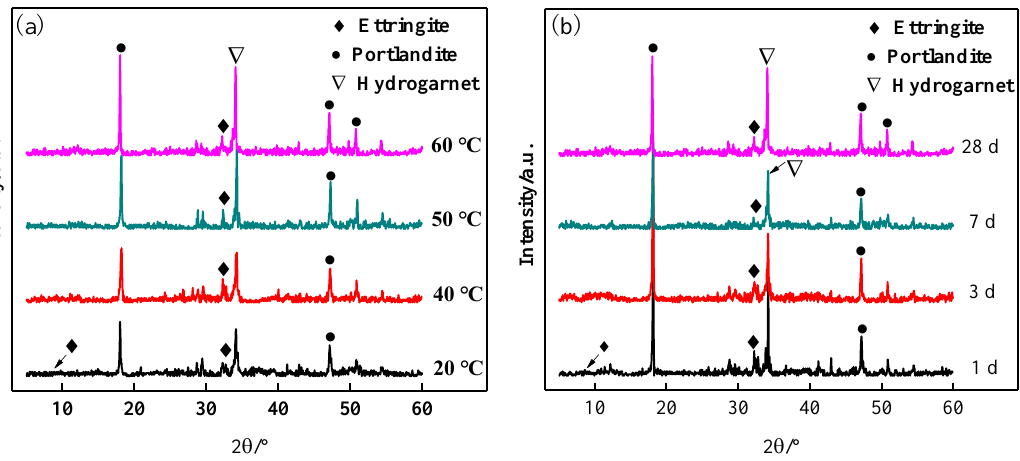
Figure 5. XRD patterns of SRPC hydration products: ( a ) at different temperatures; ( b ) at different ages.